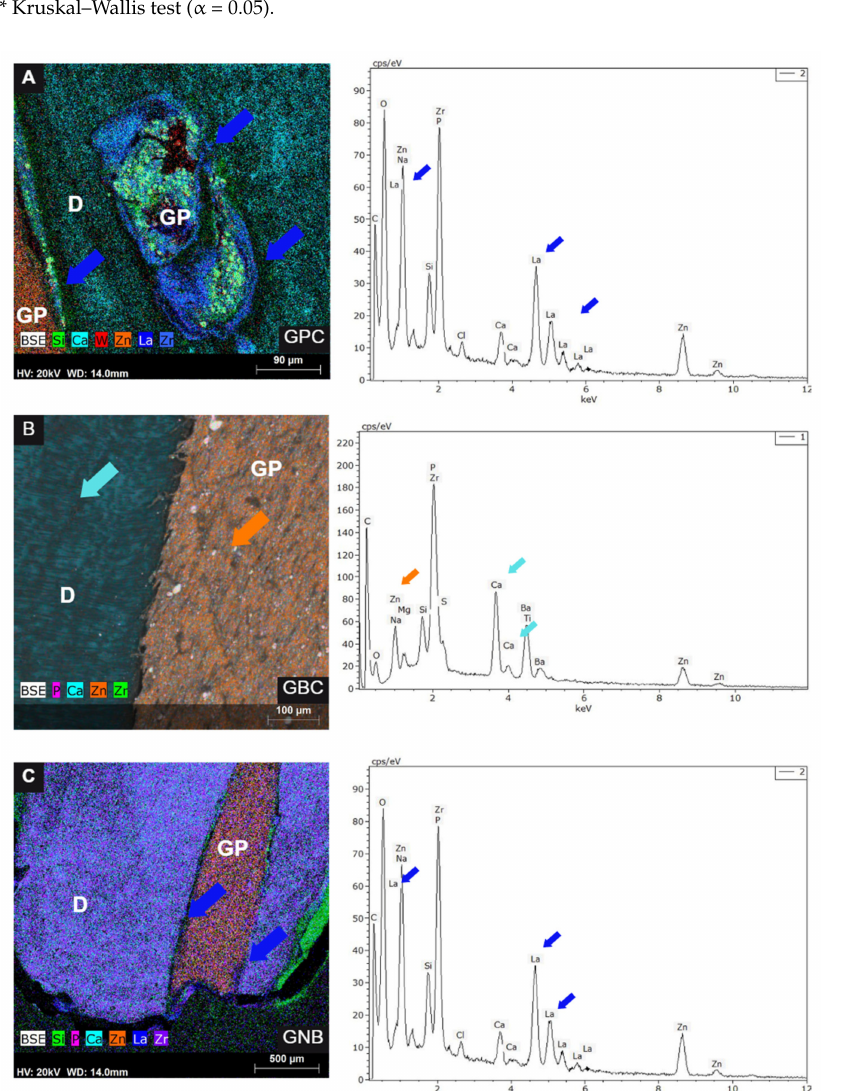
Figure 2. Representative images of lanthanum nanoleakage in all of the evaluated groups. ( A ) Con- ventional gutta-percha (GPC) group. The presence of lanthanum at the interface is indicated by blue arrows. ( B ) EndoSequence BC Sealer (GBC) group. The EDS analysis showed the presence of ele- ments such as calcium (blue arrow) and zinc. ( C ) Gutta-percha group with niobium phosphate glass (GNB). The presence of lanthanum at the interface is indicated by blue arrows. Markers: D—dentin;